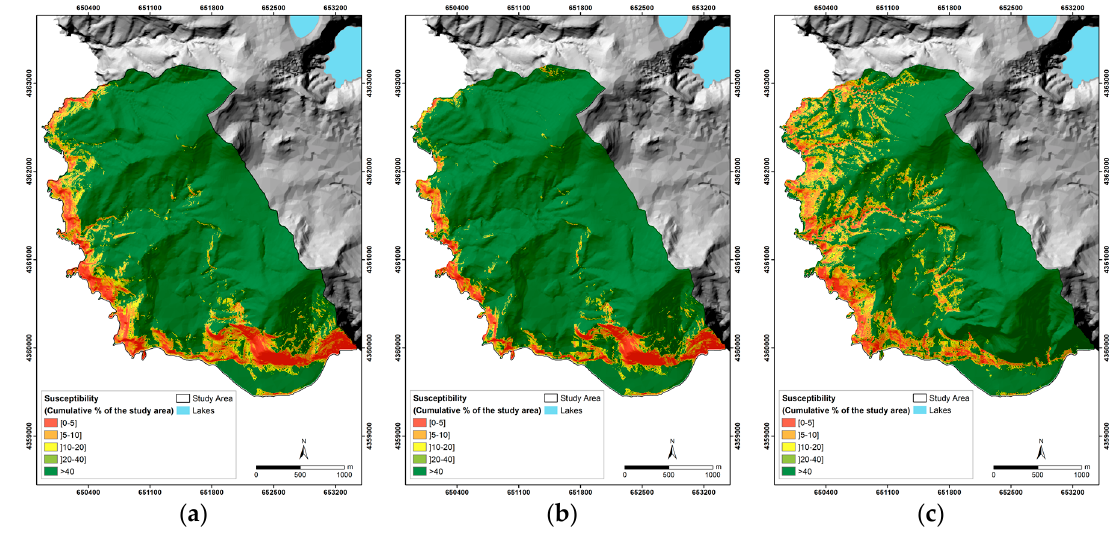
Figure 5. Landslide susceptibility maps for: ( a ) LAND-TOT group; ( b ) FALL-TOT group; ( c ) SLD-TOT group.